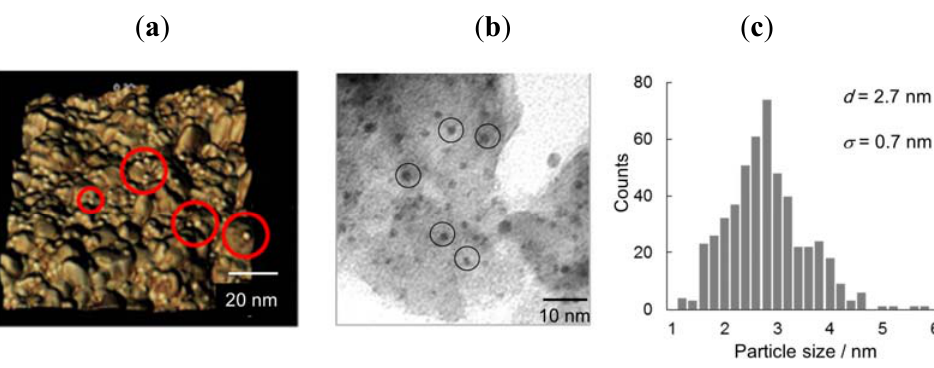
Figure 1. AFM ( a ); TEM ( b ) and size distribution ( c ) of Au NPs on